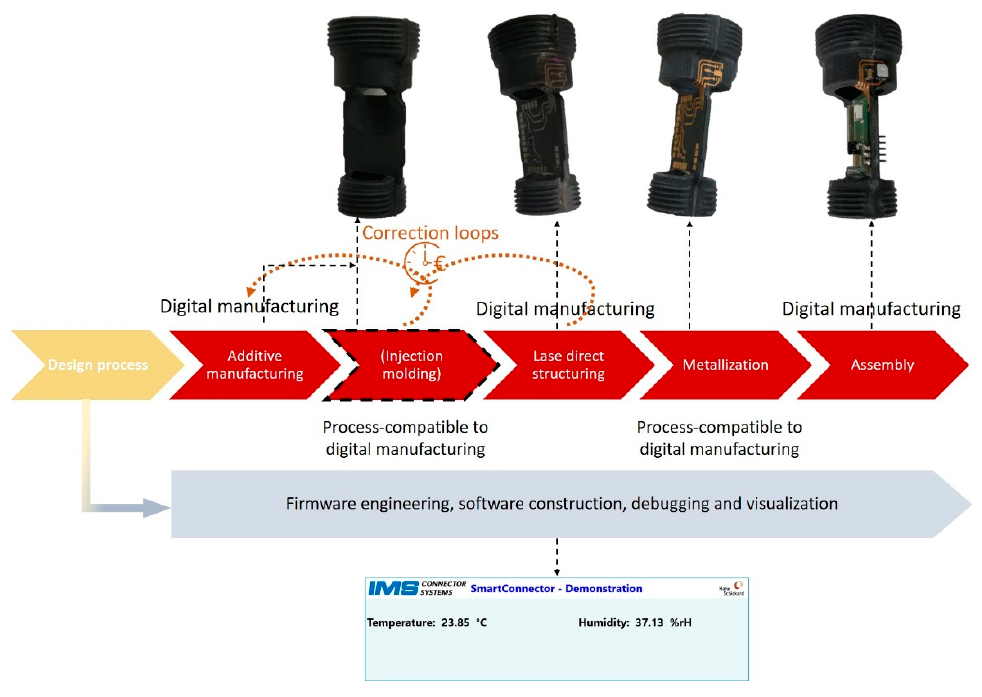
Figure 8. Implemented digital manufacturing process chain for iMMS.